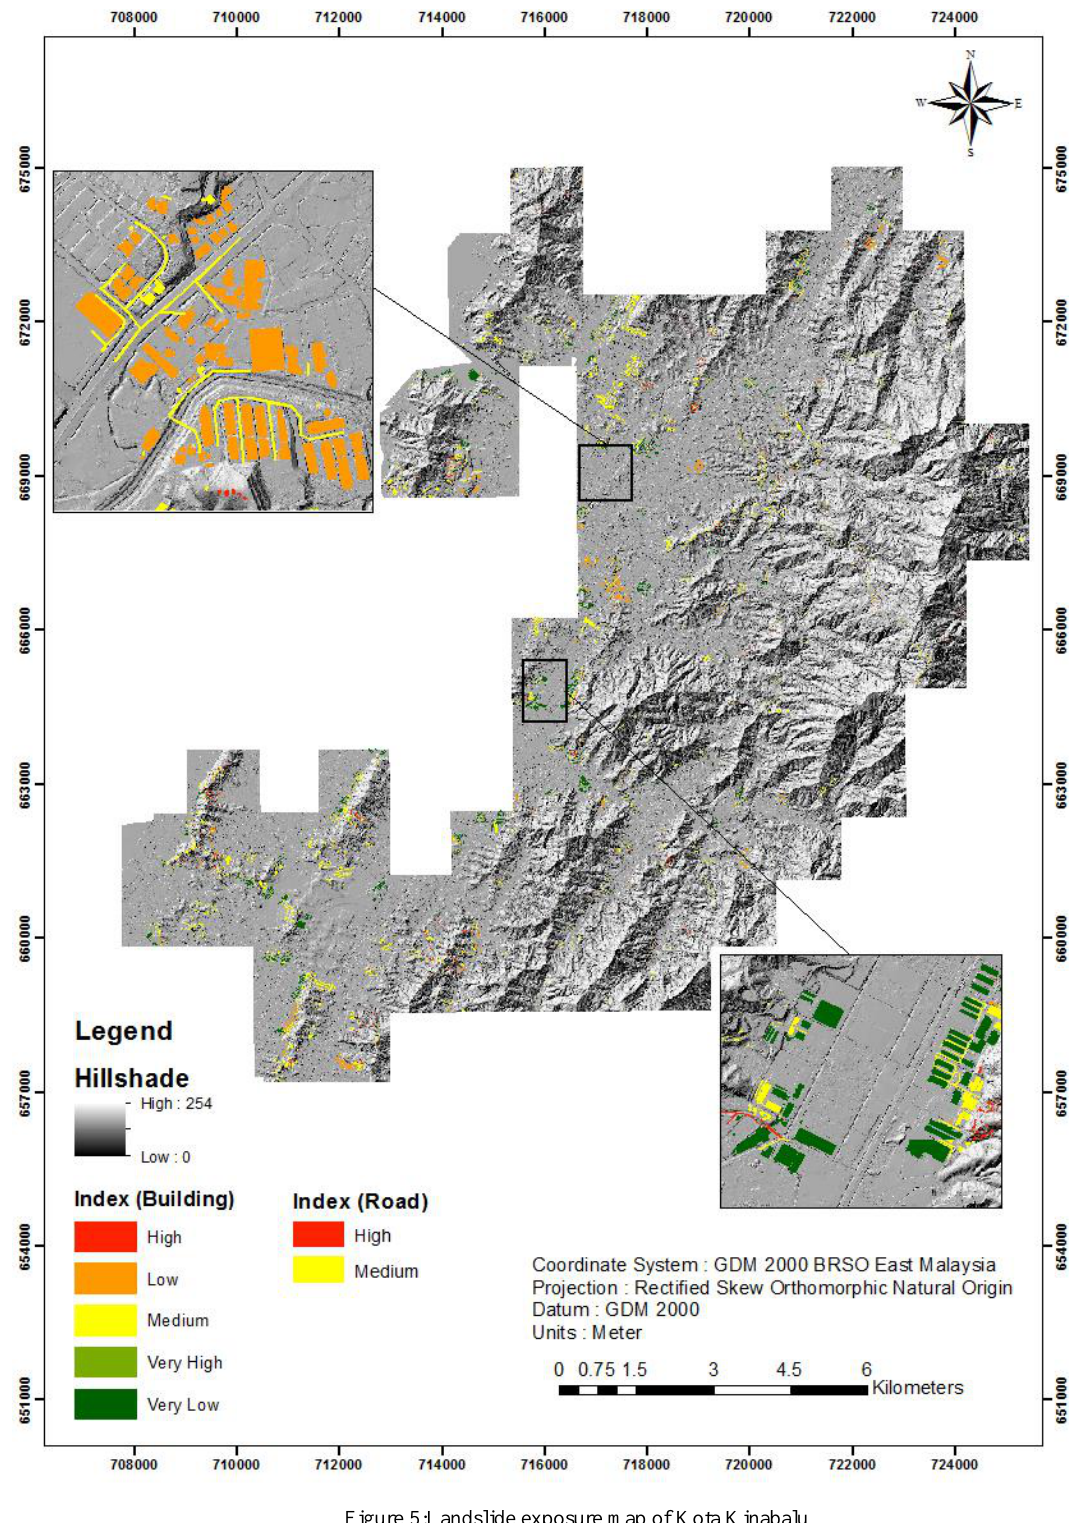
Figure 5:Landslide exposure map of Kota